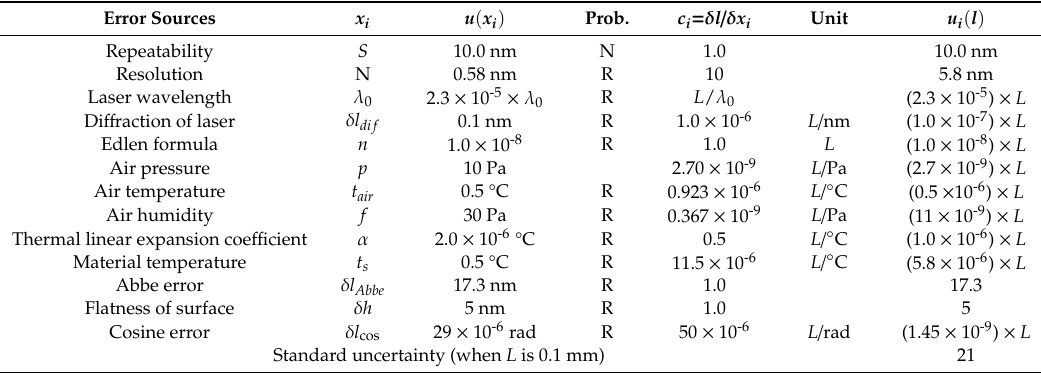
Table 1. Measurement uncertainty